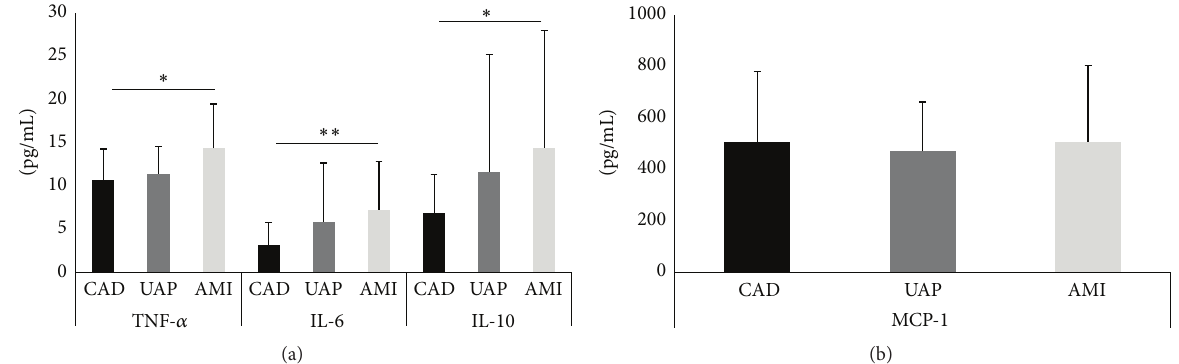
Figure 4: The data are presented as means ± SD. Profile of plasma levels of tumor necrosis factor- 𝛼 (TNF- 𝛼 ), interleukin- (IL-) 6, and IL-10 (a) and of monocyte chemoattractant protein-1 (MCP-1) (b) in the coronary artery disease (CAD), unstable angina pectoris (UAP), and acute myocardial infarction (AMI) groups. ∗ 𝑃 < 0.05 ; ∗∗ 𝑃 < 0.01